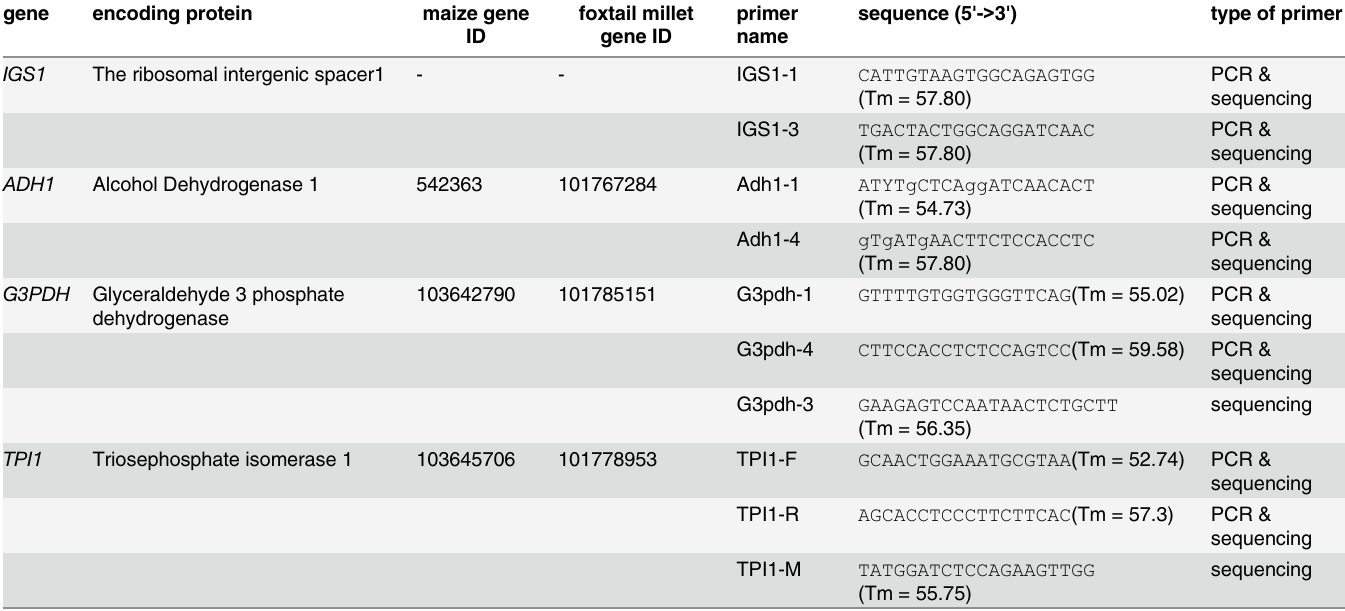
Table 1. Primers ’ information for four